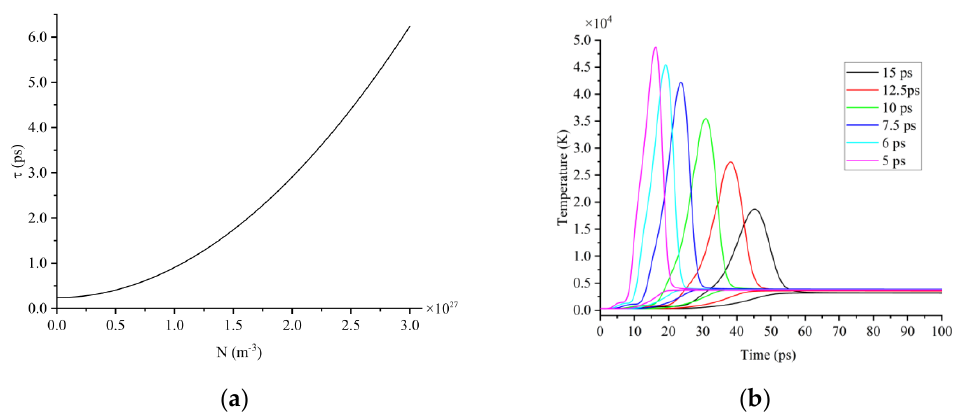
Figure 3. ( a ) Electron–lattice relaxation time; ( b ) time for electron–lattice temperature to reach equilibrium state under the action of picosecond lasers with different pulse widths as 15 ps, 12.5 ps, 10 ps, 7.5 ps, 6 ps and 5 ps.